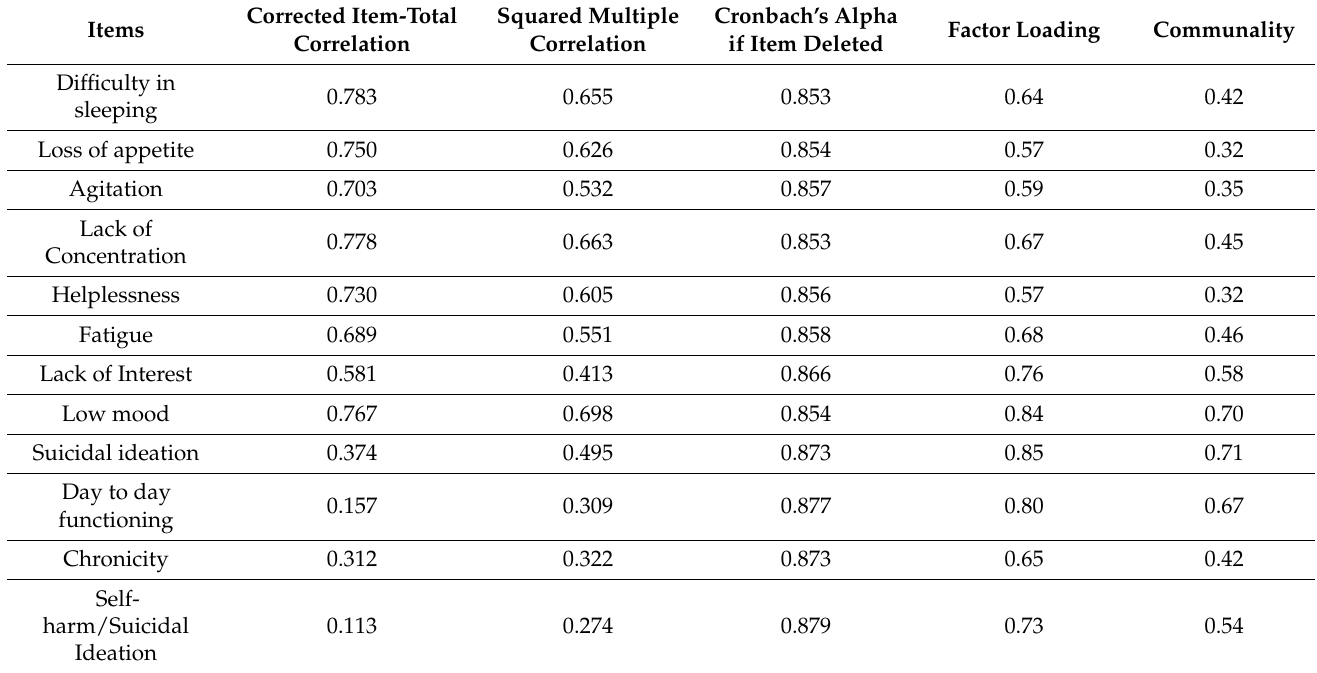
Table 2. Reliability and Factor Validity Statistics of Tool (After Deletion of Redundant